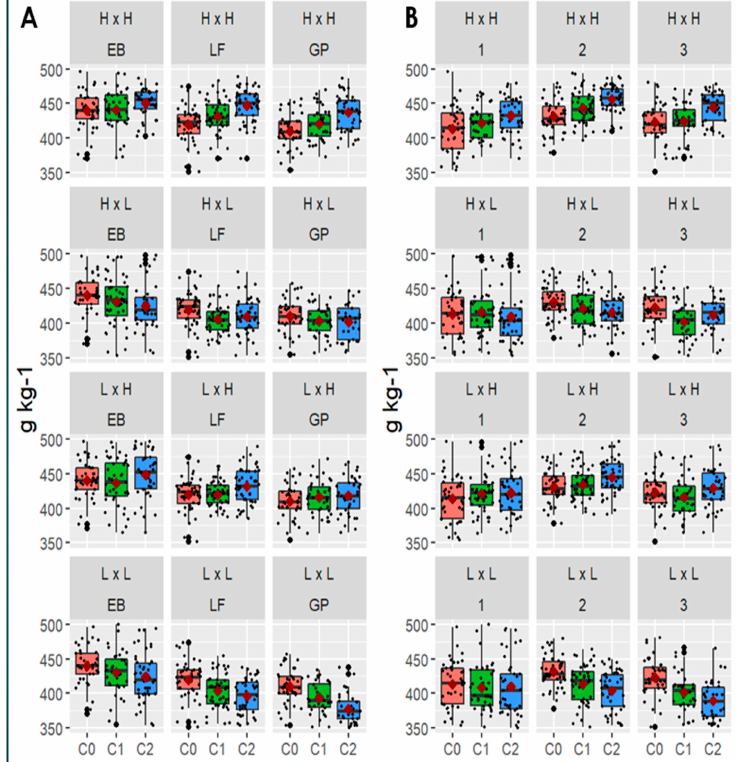
Figure 3. Effect of maturity and harvest on 96 h IVNDFD in selected populations. ( A ) Ninety-six h IVNDFD at early bud (EB), late flower (LF), and green pod (GP) maturity stages across two years, two locations, and three harvests. ( B ) Ninety-six h IVNDFD for combined maturity stages at Harvest 1, 2, and 3 across two years, two locations, and three maturities. The small dots are the individual values, and the large black dots are outliers. The red diamond inside each box is the mean value. C0, unselected population; C1, cycle 1 population; C2, cycle 2 population; H × H, intermating of plants with high 16 h IVDFD and high 96 h IVNDFD; L × L, intermating of plants with low 16 h IVDFD and low 96 h IVNDFD.